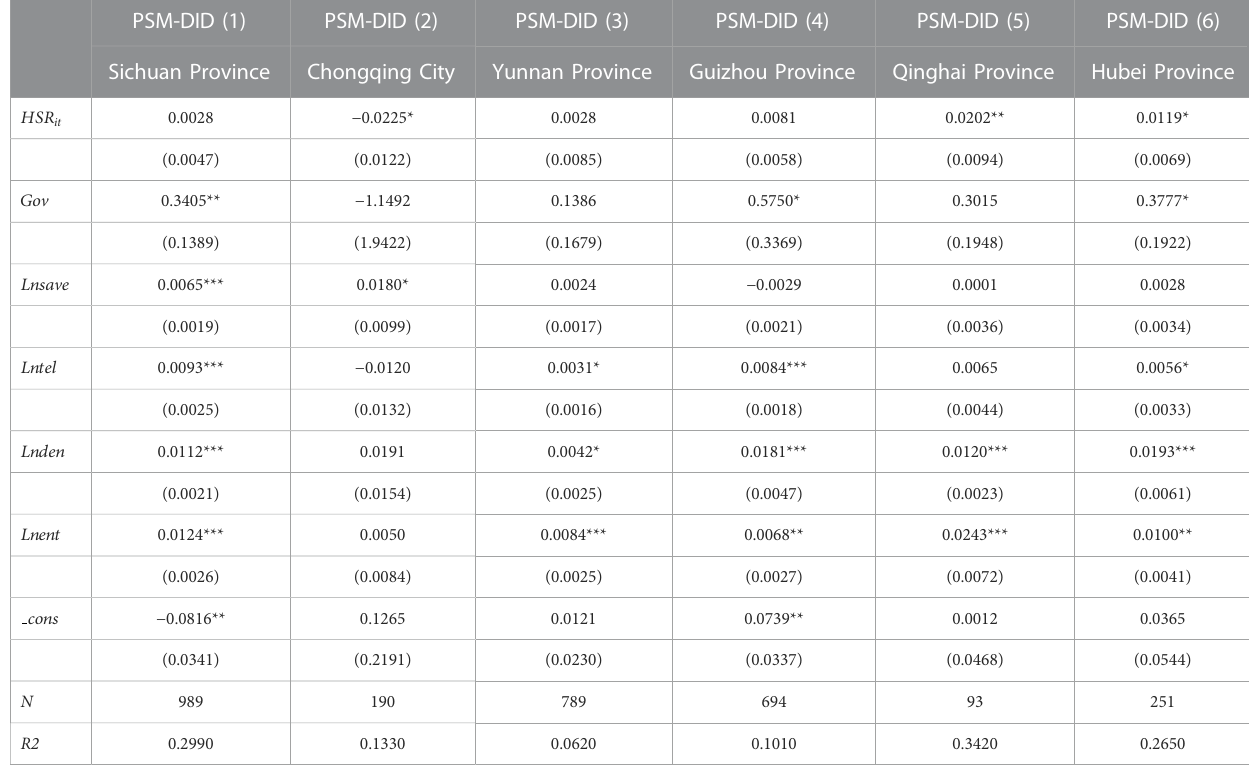
TABLE 14 Heterogeneity in different